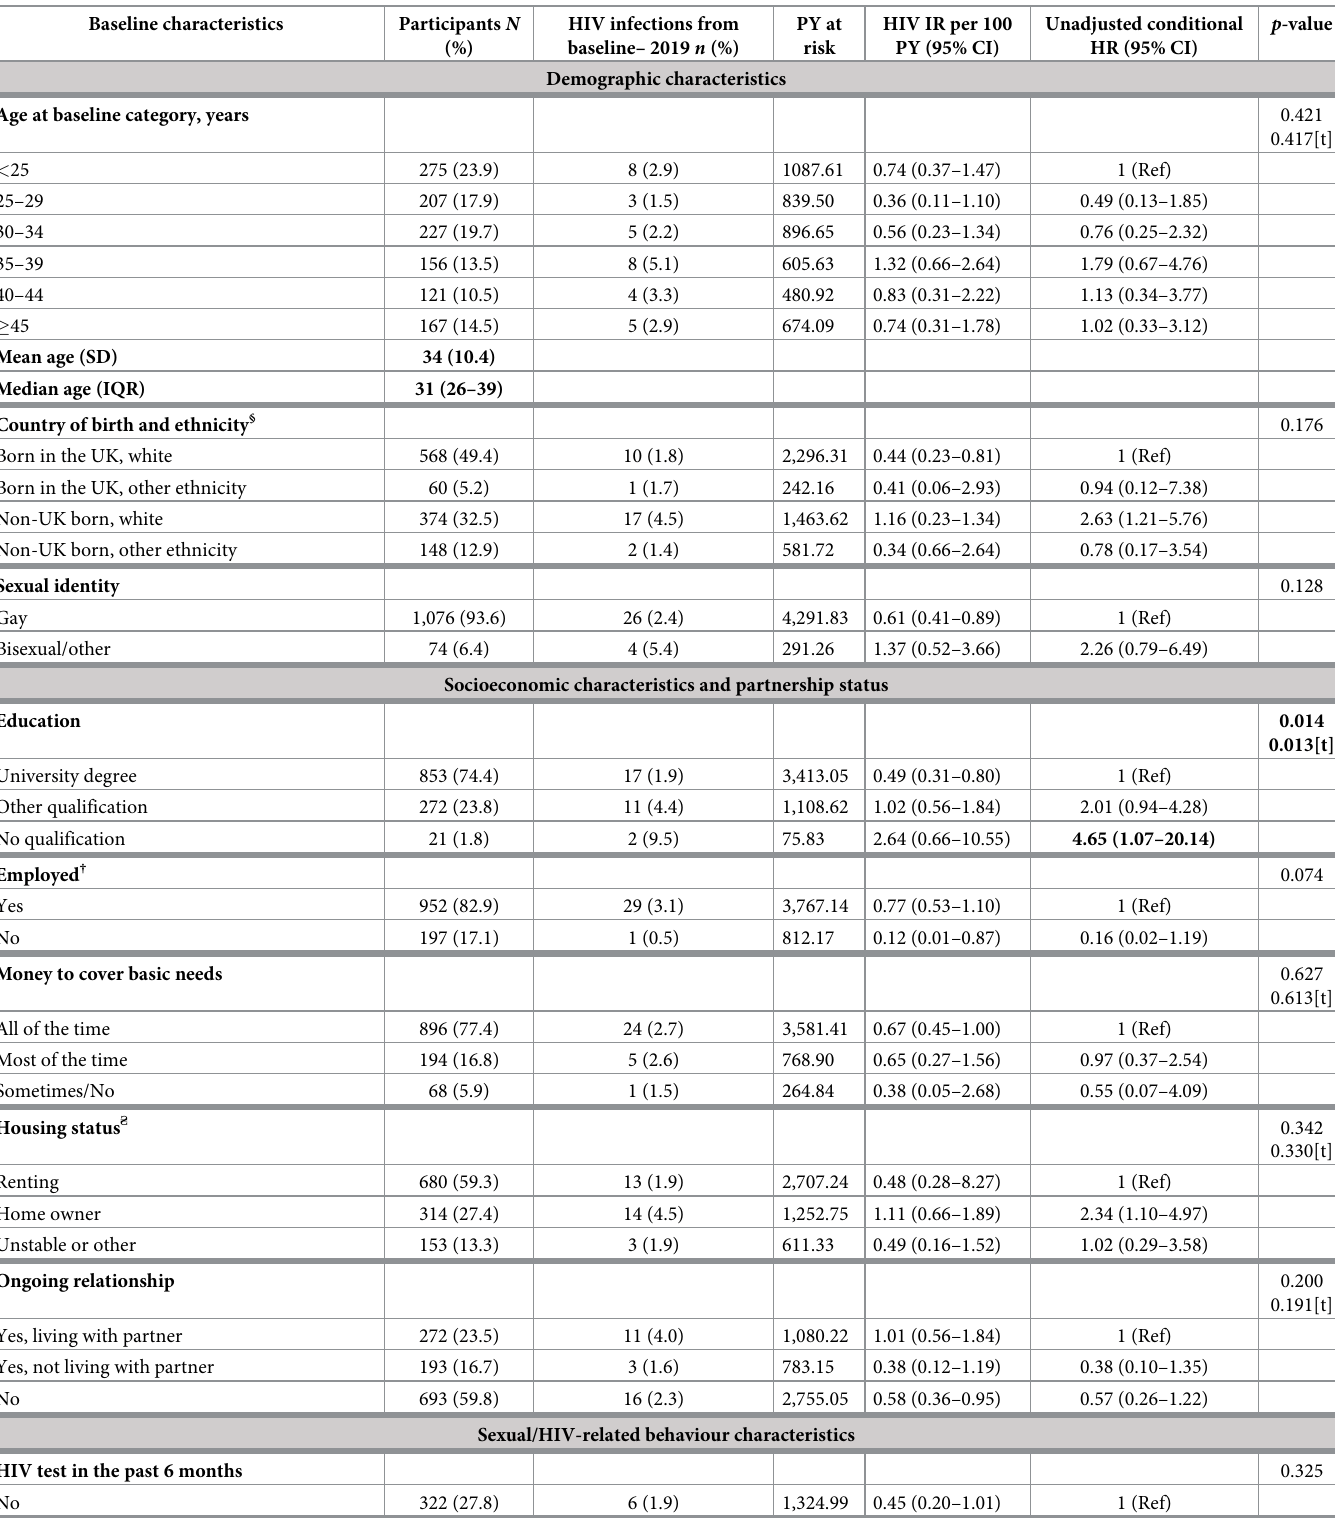
Table 1. Baseline characteristics and association with incident HIV among 1,162 GBMSM participating in the AURAH2 prospective study, 2013–2019 �